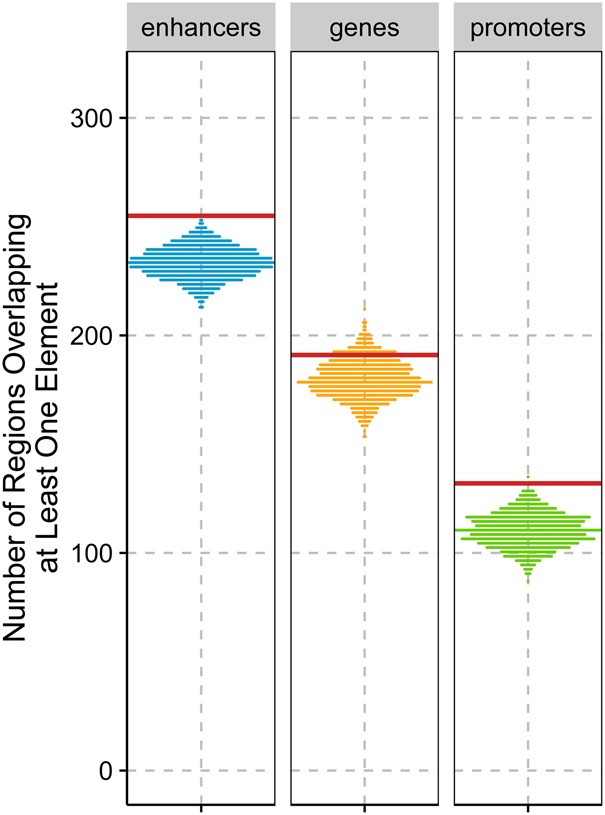
Enrichment for regulatory elements (enhancers, P-value < 0.001; protein-coding genes, P-value = 0.124; and promoters, P-value = 0.002) in the extended set of 314 candidate sweep regions. The distributions were obtained by randomly placing candidate regions in the genome to obtain lists of regions with similar physical lengths. The red lines represent the value observed in the real extended set.